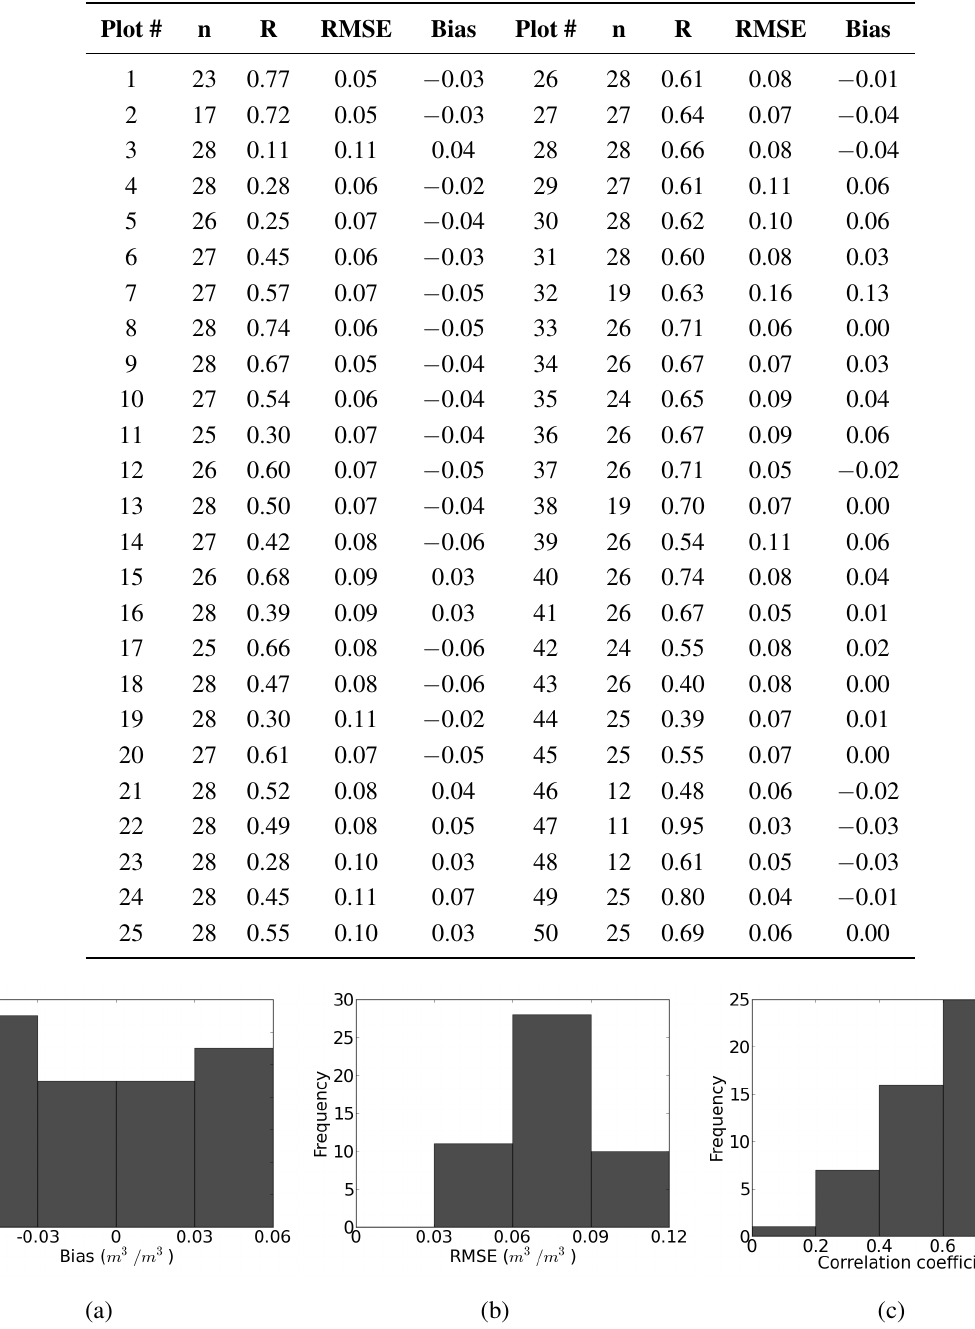
Table 3. Model performance indices of the CT model using the RADARSAT-2 HH polarization for the 50 plots. Unit for RMSE and Bias is m 3 /m 3 .